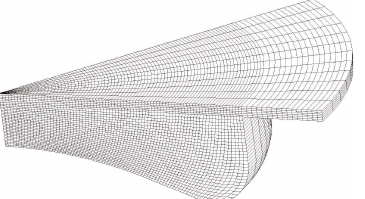
Figure 11: Computational grid of the heavy duty DI diesel engine.